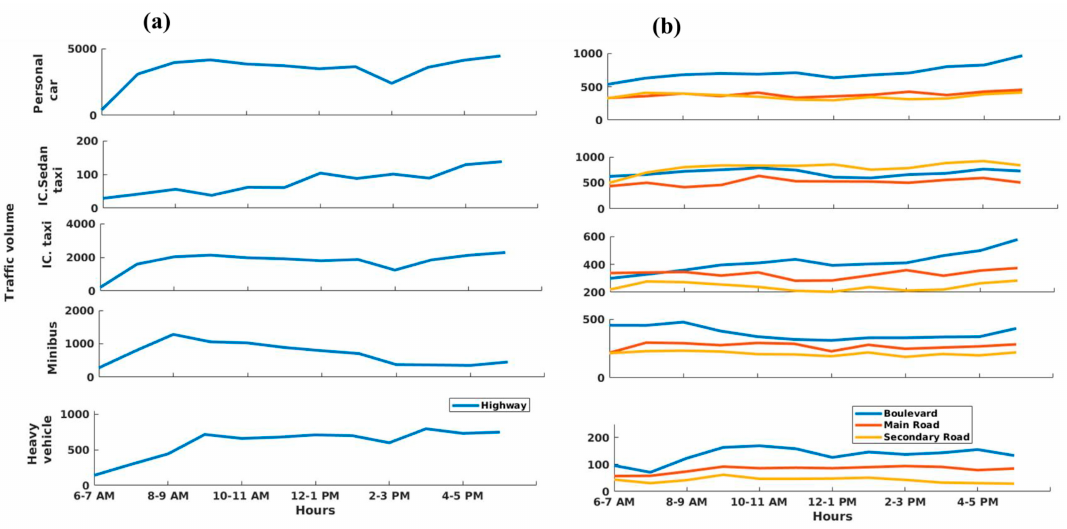
Figure 6. Traffic flow of each vehicle class per type of road. Highway ( a ), and boulevard, main road, and secondary road ( b ). From top to bottom, respectively, personal car, intercommunal sedan taxi, intercommunal taxi, minibus, and heavy vehicle.